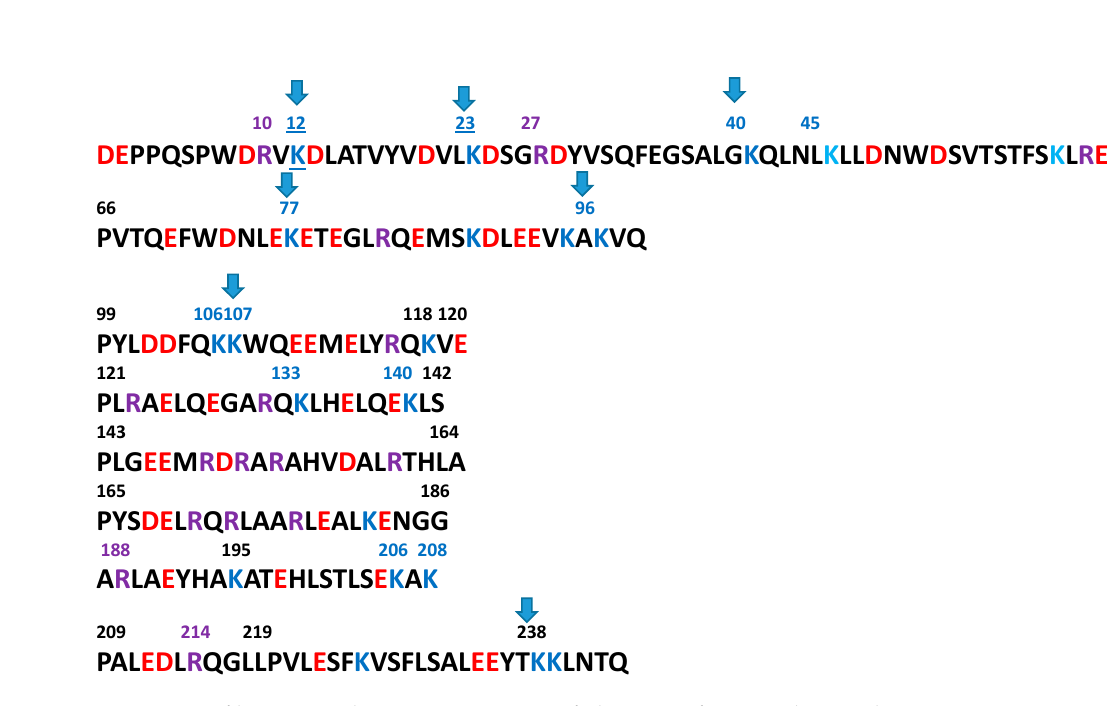
Figure 1. Sequence of human apoliprotein A-I. Points of glycation of Lys residues in the apoA-I sequence are shown by the arrows. Glycation of apoA-I perturbs the lipid-associating property of apoA-I, thus rendering HDL unstable. Acidic amino acids are in red. Lys residues are in blue and Arg residues in purple. Arrow marks represent the points of glycation of Lys residues.